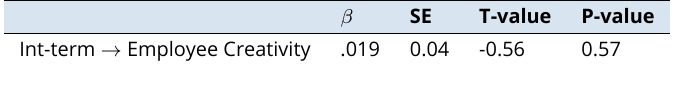
(cid:12) SE T-value